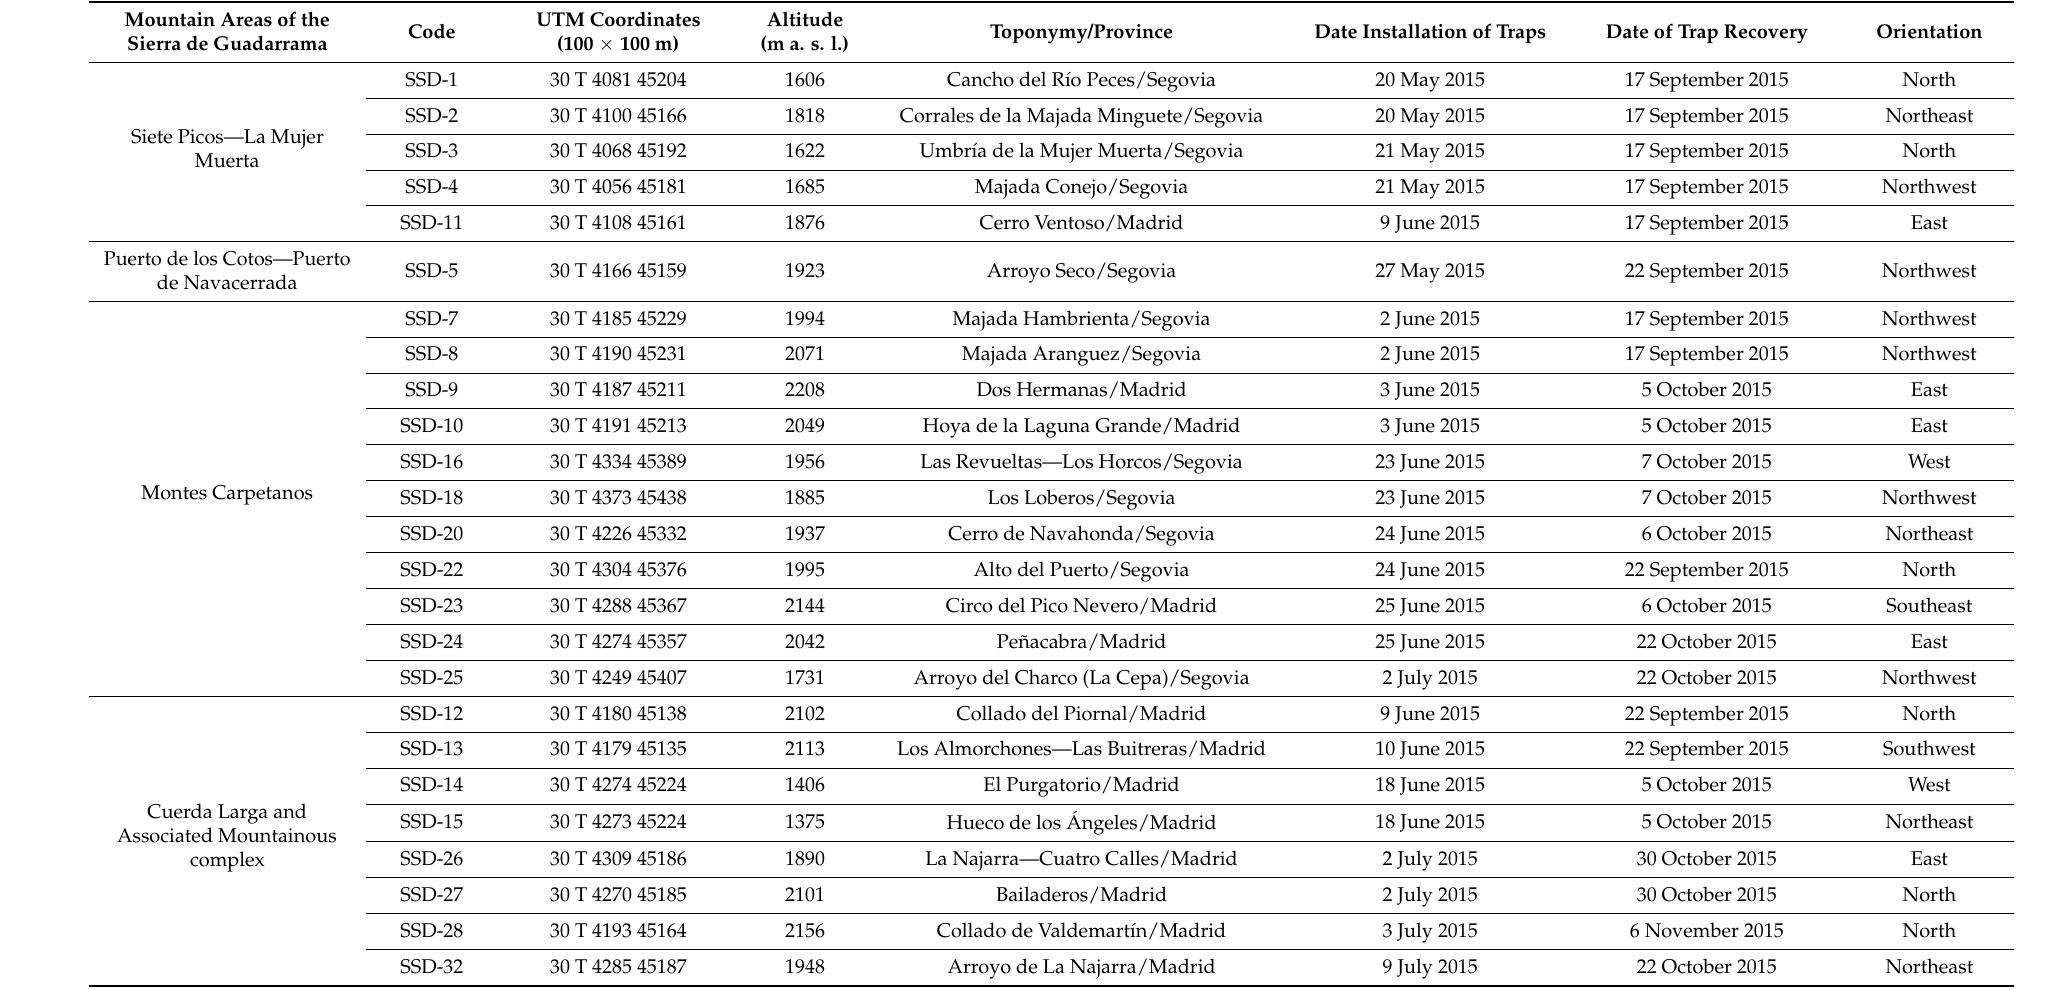
Table 1. Location of traps (SSD, subterranean sampling